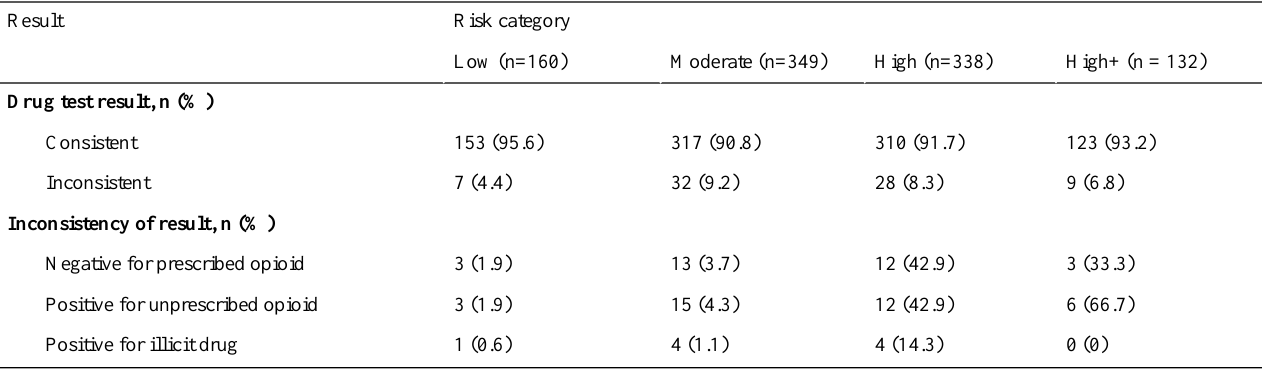
Table 2. Consistency of drug tests with the prescribed opioid therapy in the 4 risk categories of the UDT Randomizer tool. Risk categoryResult